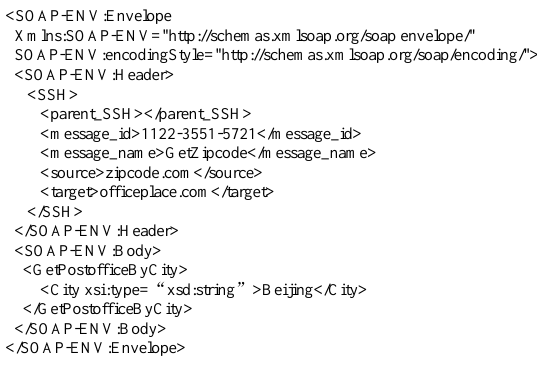
Fig. 2. A sample of SOAP message fragment with